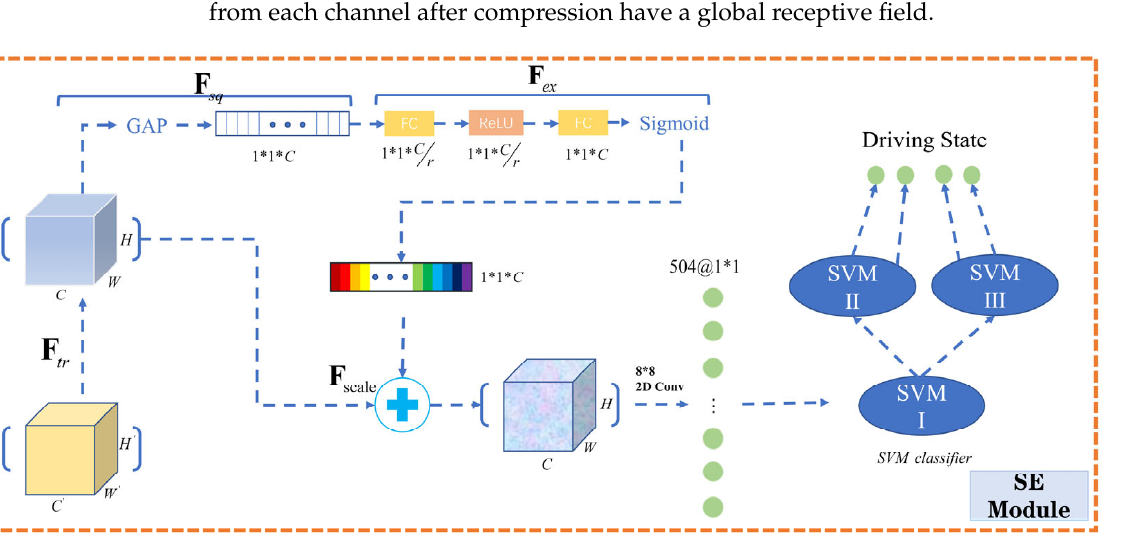
Figure 5. Attention mechanism SE module.